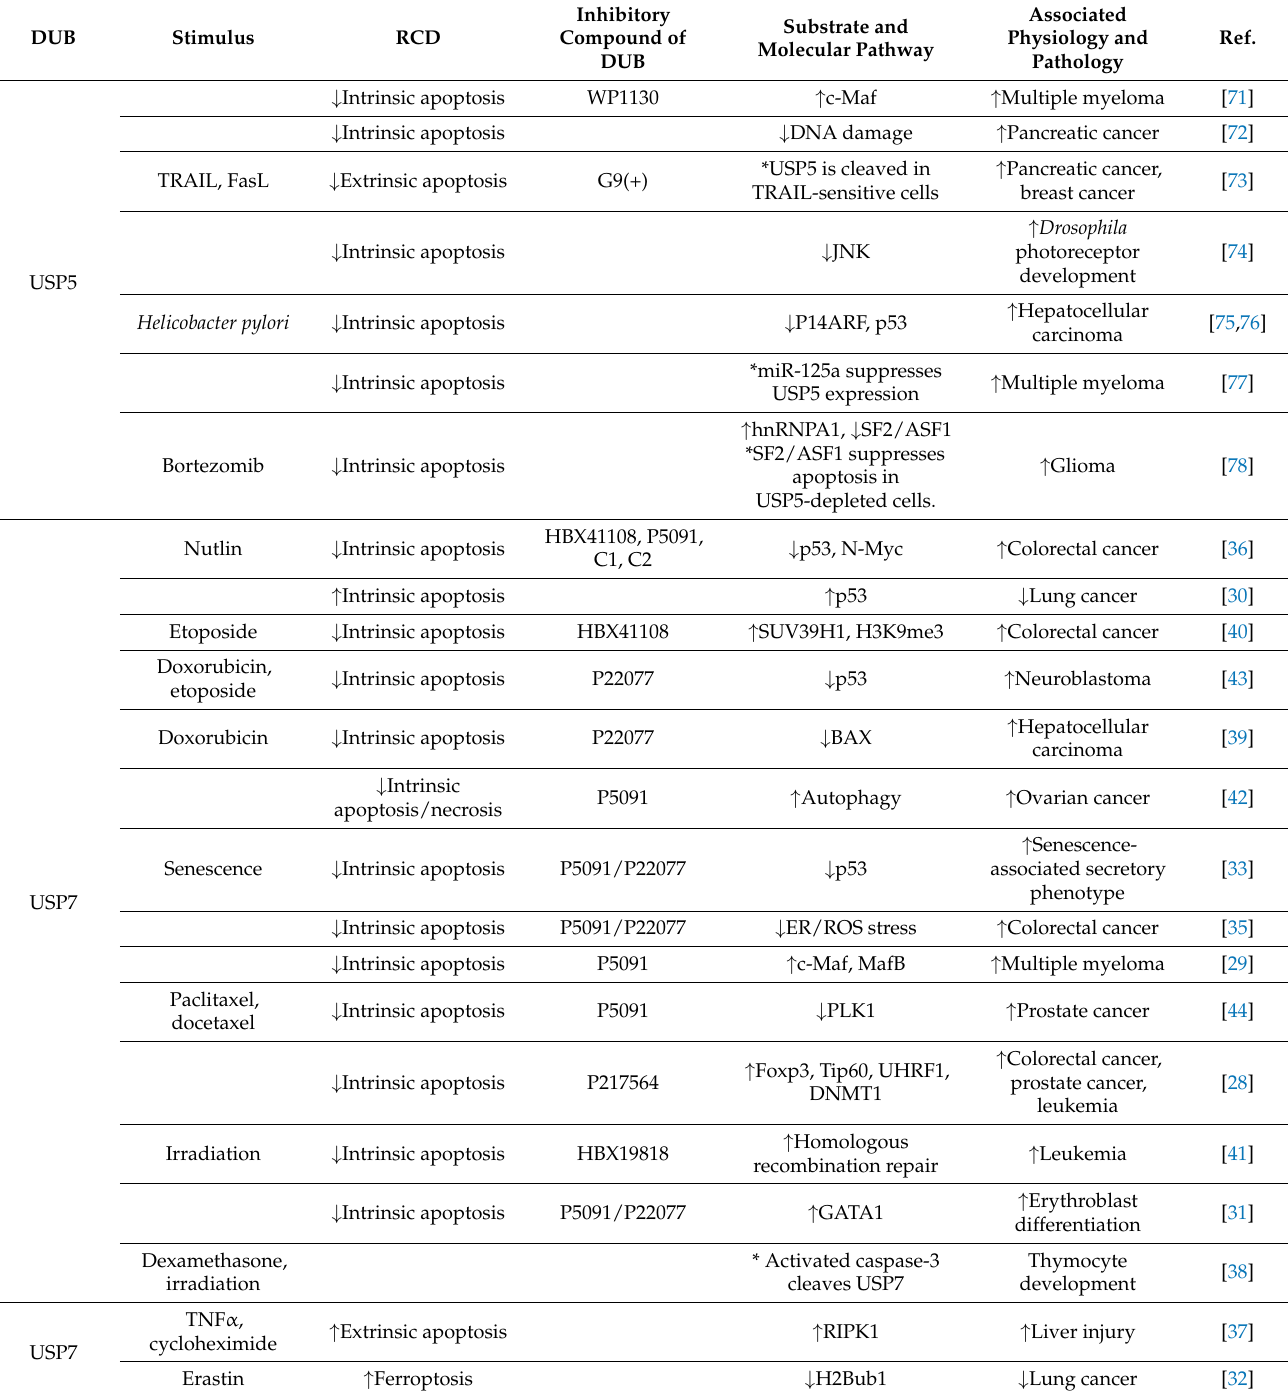
Table 1. The list of deubiquitinases regulating multiple types of RCD